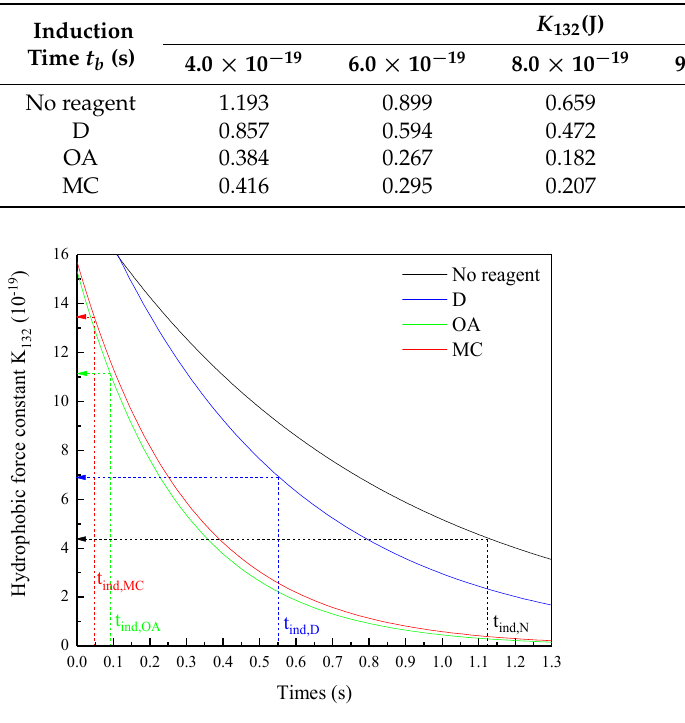
Figure 7. The functional relationship between hydrophobic force constant and induction time. Table 5. Hydrophobic force constant between air bubbles and coal particles treated with different